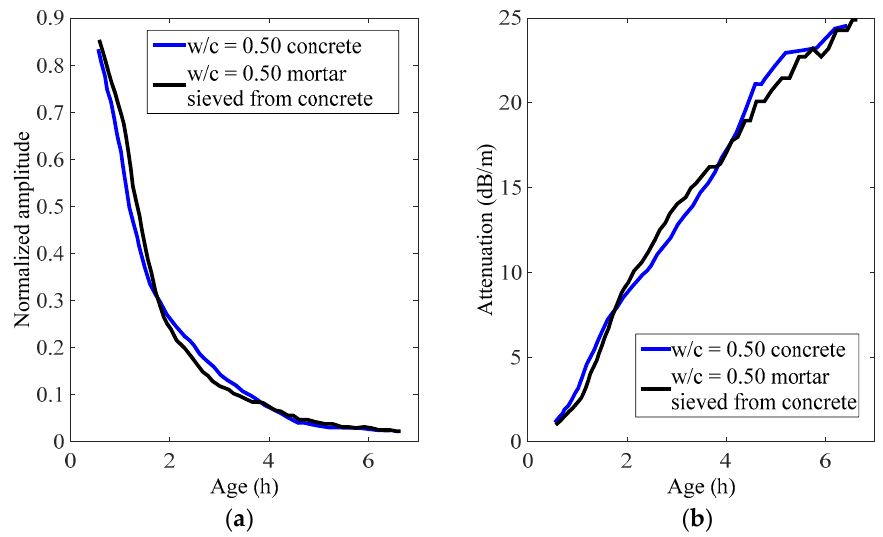
Figure 9. Guided waves in concrete and mortar sieved from concrete: ( a ) normalized amplitude and ( b ) attenuation.